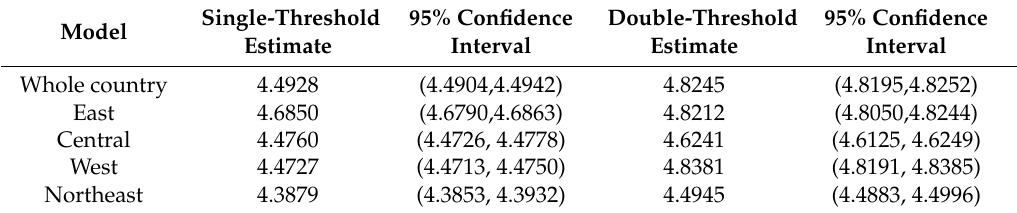
Table 6. Estimates of the economic development